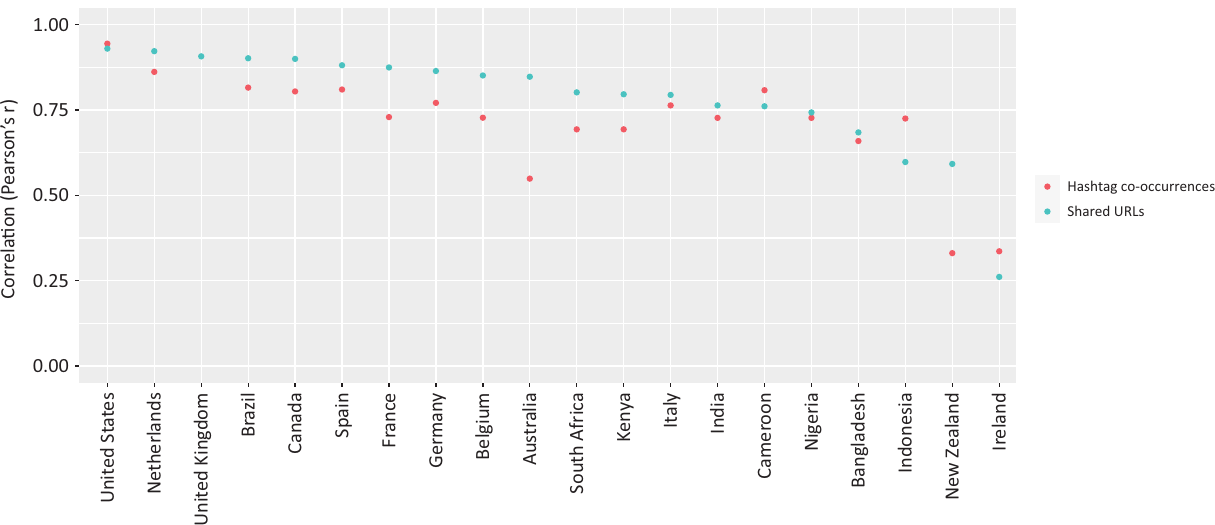
Figure 4. Indicators of cross-referential cohesion (correlations of hashtag co-occurrences, shared URLs) per country. Notes: Only the 20 most frequent countries in the dataset were included. Sorted in descending order by correlation of shared URLs. N (tweets) = 6,041,024; N (unique domains) = 37,271; N (co-occurring hashtags) = 291,053. Source: Author, prepared with R